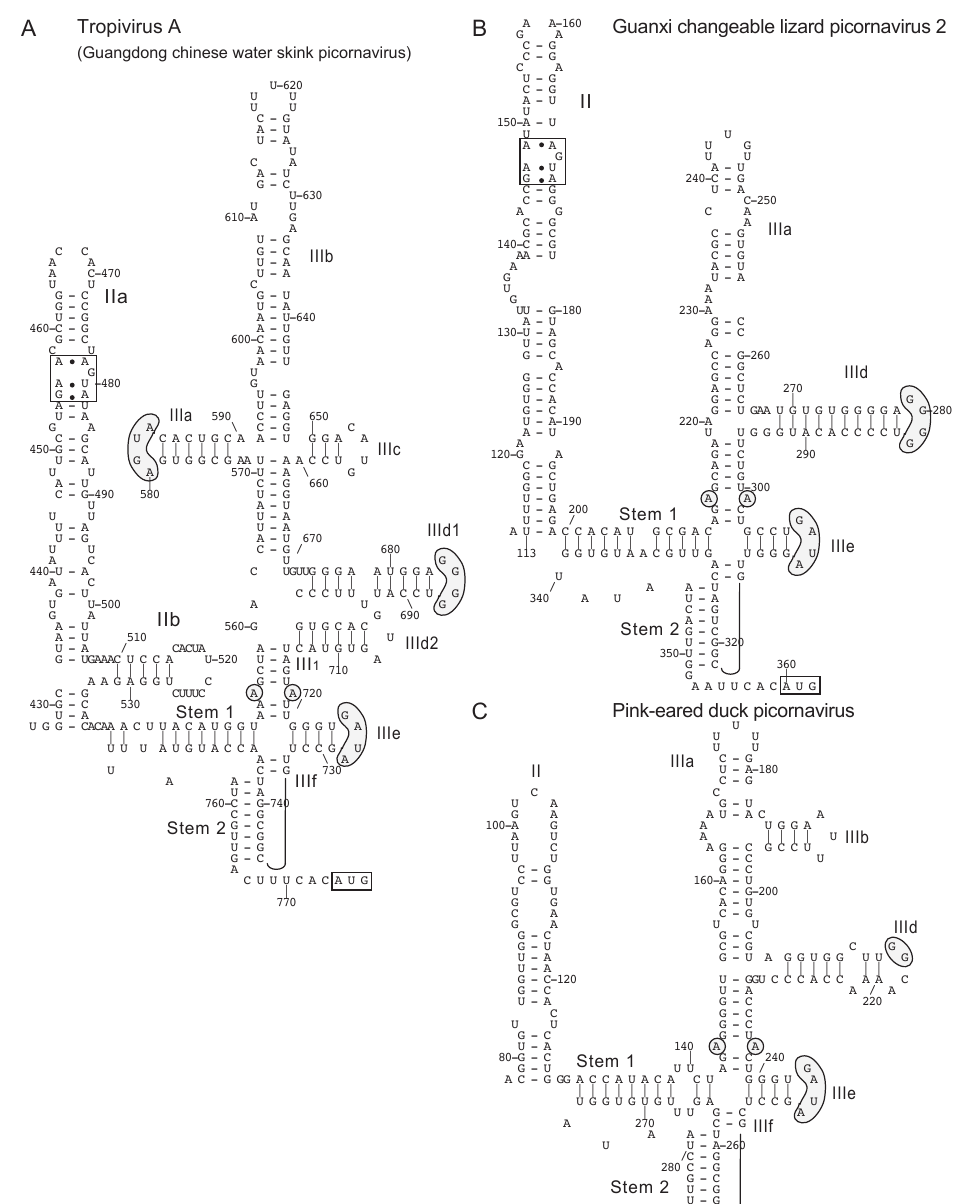
divided to show a homologous element near the 5 (cid:48) -end (shaded light blue), the type III IRES in hepatovirus A and the type IV IRES in hepatovirus C. The nucleotides forming these noncoding elements and the N- and C-terminal amino acid residues of the polyprotein are numbered, and the nucleotide or amino acid sequence identity between them is indicated, as appropriate. ( B ) The model of the secondary and tertiary structure of this hepatovirus C IRES was derived as described for related IRESs [114,130]. Domains are labeled II - IV, subdomains are labeled IIIa, IIIb etc, Stem 1 and Stem 2 are elements of the pseudoknot, and helix III 1 is the basal element of domain III. The initiation codon for the viral polyprotein (AUG 528 ) is indicated by black box. Sequence motifs in domain III that are characteristic of type IV IRESs are indicated by grey shading.